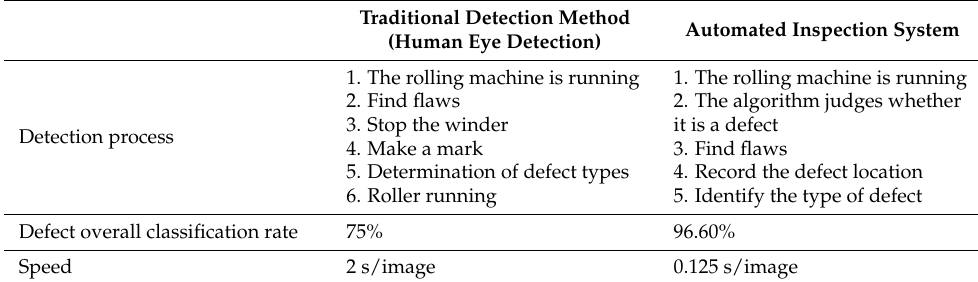
Table 2. Comparison between the traditional detection and the automatic detection proposed in this